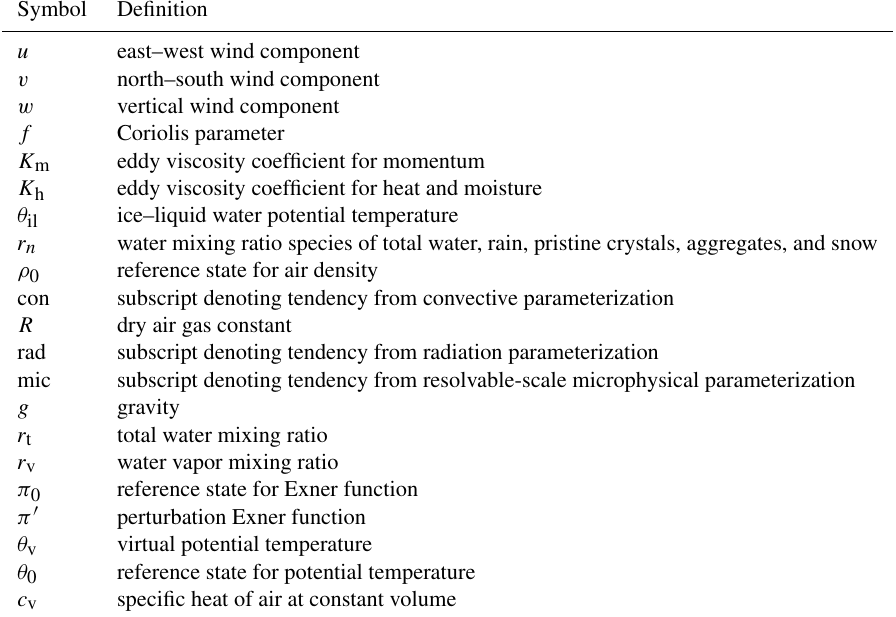
Table 1. List of